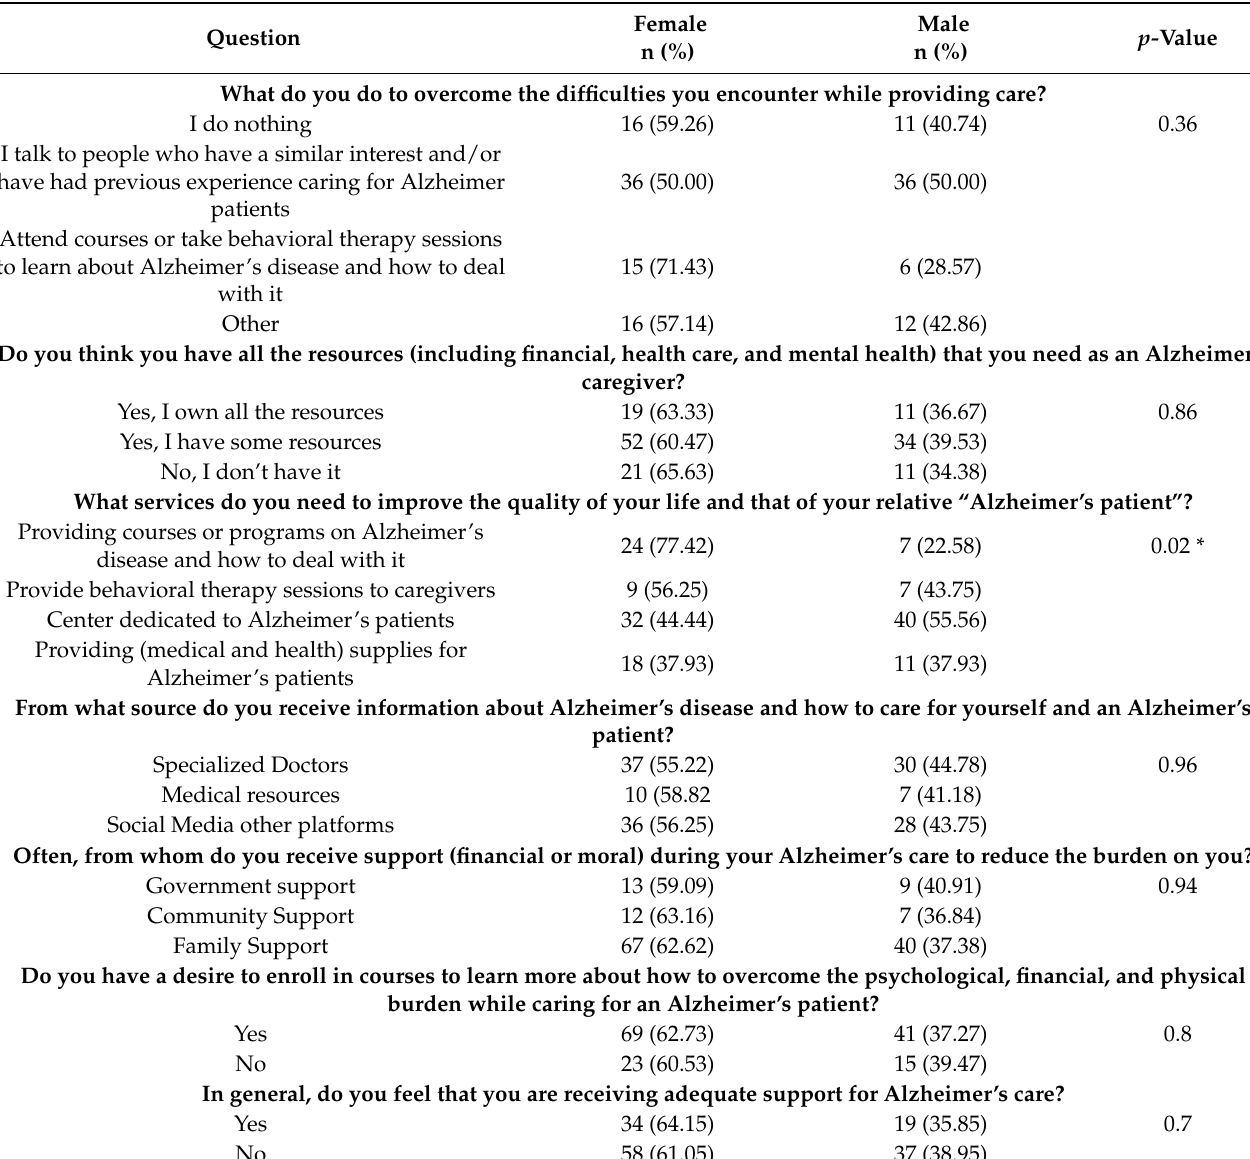
Table 3. Information on Coping Strategies and Support for Caregivers of Alzheimer’s